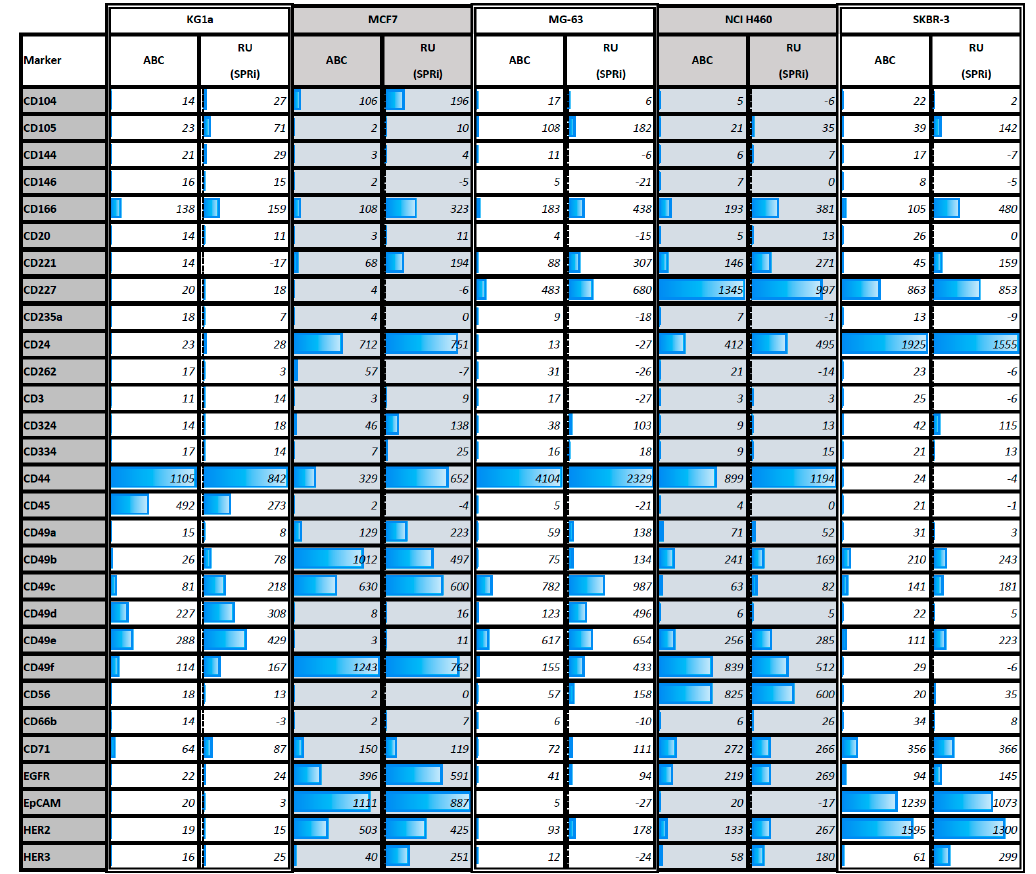
Figure 3. Graphical representation of the result table. The flow cytometric Antibody Bound per Cell (ABC) values and Resonance Units (RU) values of SPRi of five di ff erent cell lines are shown for 28 markers. In total, 16 markers were left out because these markers did not show any or a very weak response for all five cell lines (for the full unedited table including correlations see Supplemental Table S1). The total SPR signal per column was used to normalize the ABC signal with the SPR signal. It shows that all cell lines are di ff erent but some lines are “closer” to each other. E.g., the cell line KG1a and MG63 (ATCC CRL-1427 ™ ) behave similar over the various markers but are di ff erent with respect to CD45.